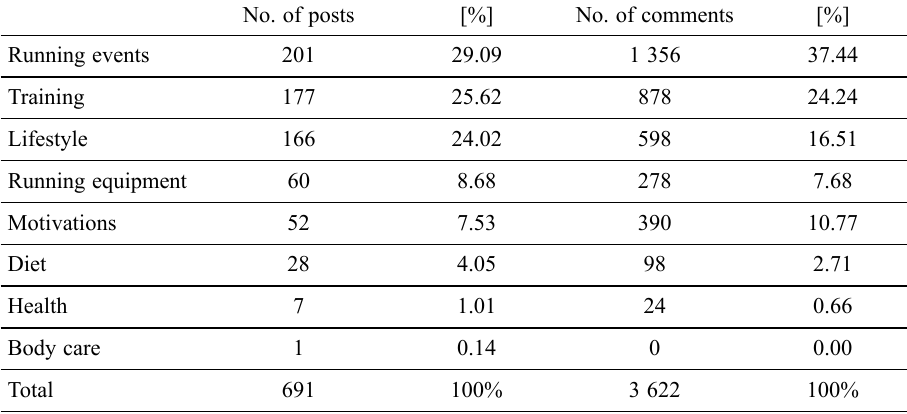
Table 3. Ranking of topics of entries, including the number of comments